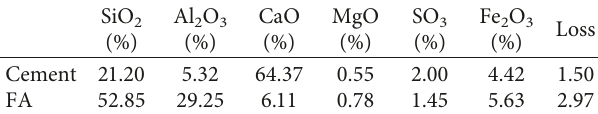
Table 1: Properties of coarse aggregates [16]. Table 2: Chemical composition of cement and FA [16].